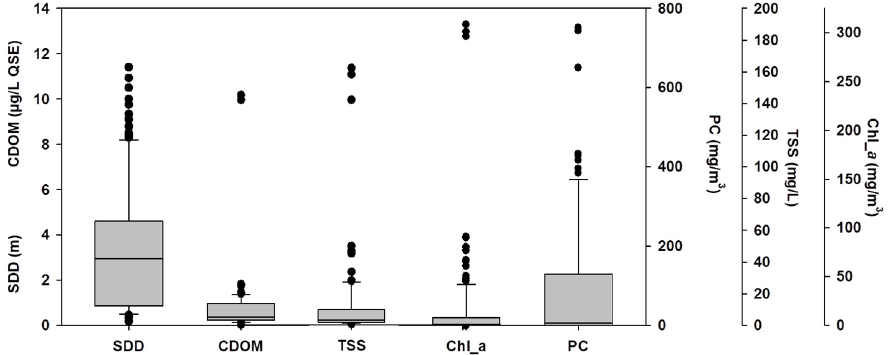
Figure 2. Boxplot of the values range for the water quality parameters. The box bounds the interquartile range (IQR; 25–75 percentile), the horizontal line inside the box indicates the median, and the whiskers (error bars) indicate the 90th above and 10th below percentiles. Dots indicate the outliers. Table 4. Spearman correlation coefficients, probability value and data points (in parenthesis).